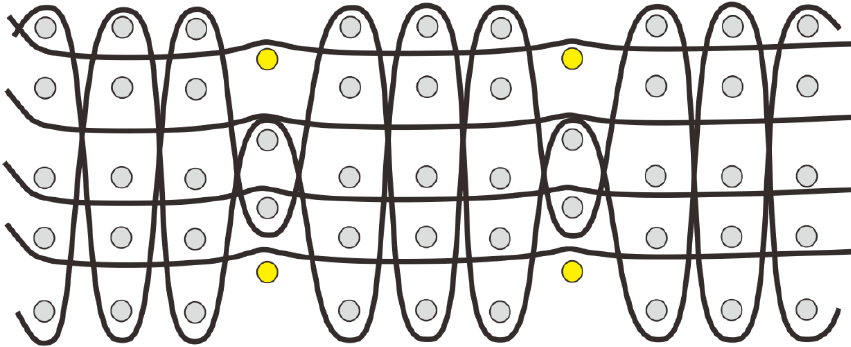
Figure 9. Optical fibers in woven fabric material consisting of different layer